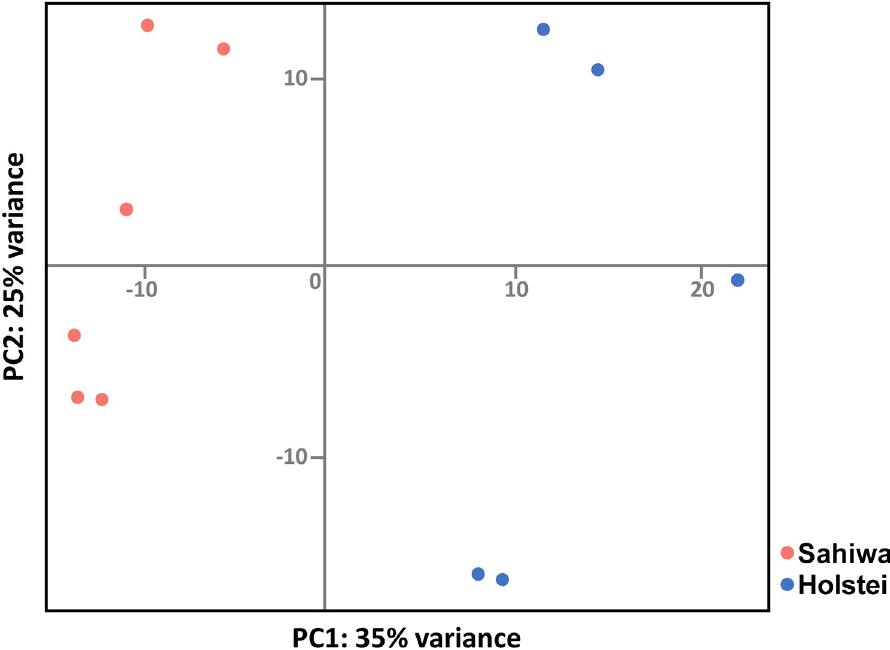
Fig 1. Clustering of samples by host breed. A PCA plot showing clustering based on the H/S-DE data set derived from five samples of Holstein (blue) or six samples of Sahiwal (red) cell lines infected with the T . annulata